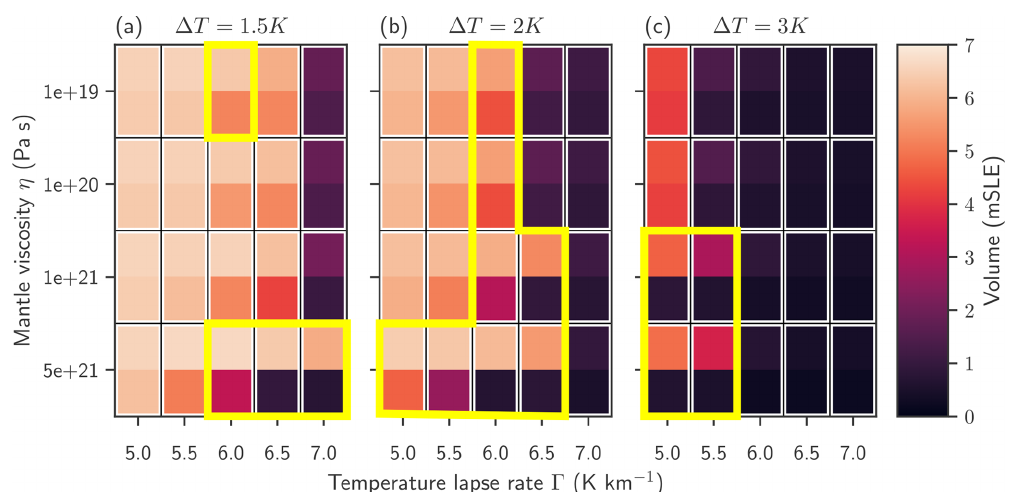
Figure 6. Minimal and maximal volumes after initial ice loss for three different warming temperatures, (cid:49)T = 1 . 5, 2 and 3K. Two pixels represent the minimal (lower) and the maximal (upper) long-term volumes for each parameter combination. The minimal and maximal long- term volume is defined by the minimum or the maximum of the volume after passing the initial minimum. A significant difference between the minimal and the maximal volume indicates oscillation. The yellow outline highlights the parameter space of the oscillating regime.